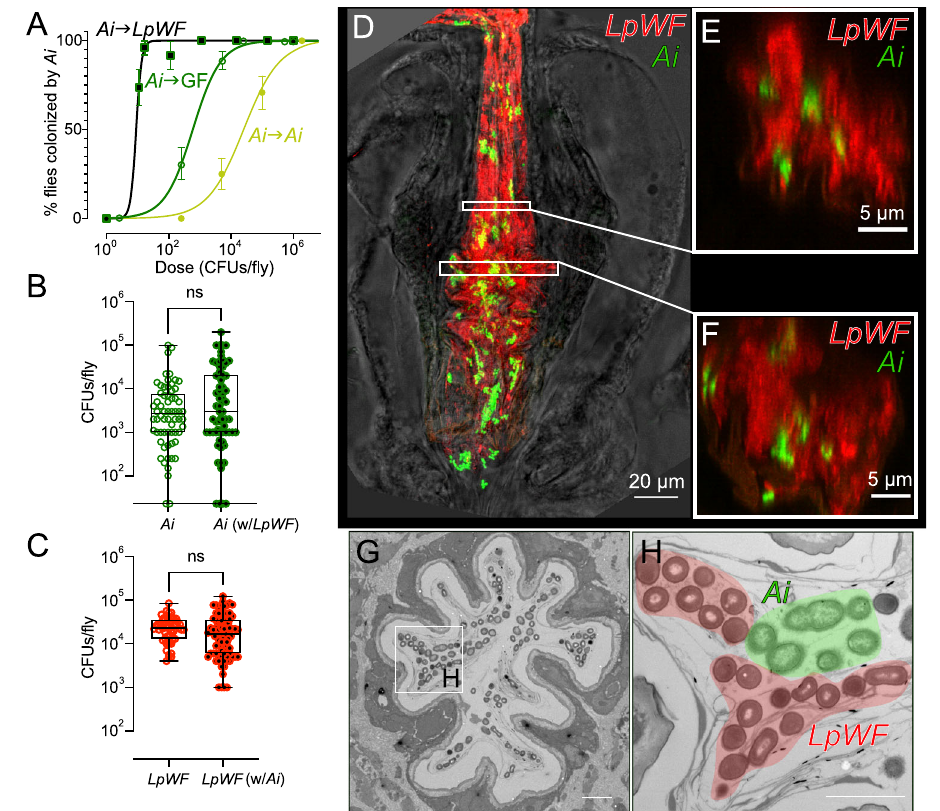
Fig. 3 | Ai and LpWF occupyseparate niches withintheproventriculus. A Strain interactions in fl uence colonization ef fi ciency, as seen by dose-response curves for Ai fed to germ-free fl ies (open green circles), Ai -pre-colonized fl ies ( fi lled yellow circles), or Lp -pre-colonized fl ies (black- fi lled green squares). Z-test of differences in proportion versus Ai into germ-free fl ies: dose 10 2.3 CFUs/ fl y, p =8.1×10 − 4 ; dose 10 3.7 CFUs/ fl y: p =4.8×10 − 9 ; dose 10 5 CFUs/ fl y: p =8.7×10 − 6 . n ≥ 12 fl ies/data point. Error bars represent 1 standard error of the proportion. B Ai abundance at 5 dpi does not differ between fl ies mono-colonized with Ai versus pre-colonized with LpWF then fed Ai . n ≥ 65 fl ies/treatment; two-tailed unpaired t-test, p =0.38; ns indicates not signi fi cant. C LpWF abundance 5 dpi does not differ between fl ies